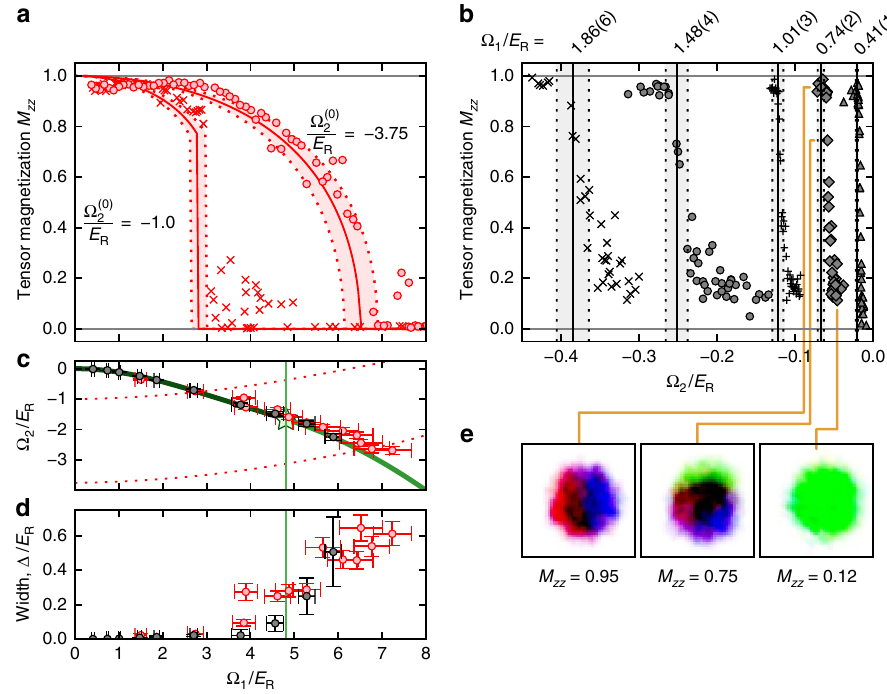
Figure 2 | Measured phase transition. ( a ) Tensor magnetization M zz measured as a function of O 1 , showing both second-order [ O 2 ( O 1 ¼ 0) ¼ (cid:4) 3.7500(3) E R ] and first-order [ O 2 ( O 1 ¼ 0) ¼ (cid:4) 1.0 E R ] phase transitions in comparison with theory. These curves followed the nominally horizontal trajectories (see Methods) marked by red dashed curves in c . ( b ) Tensor magnetization measured as a function of O 2 at O 1 / E R ¼ 1.86(6), 1.48(4), 1.01(3), 0.74(2), and 0.41(1), plotted along with the predicted critical O 2 . In a , b the light-coloured region reflects the uncertainty in theory resulting from our E 5% systematic uncertainty in O 1 . ( c , d ) Phase transition. Black (red) symbols depict data obtained using vertical (nominally horizontal) cuts through the phase diagram. ( c ) measured phase transitions plotted along with theory: solid (phase transition), and green vertical line (tricritical point, O (cid:5) bars correspond to one s.d. on O 1 and vertical error bars are the 95% confidence intervals from the fitting function that determines the critical point. ( d ) 20 to 50% transition width showing the clear shift from first- to second-order with increasing O 1 . ( e ) Domain formation for O 1 ¼ 0.74(2) showing interaction- driven spin structure near the first-order phase transition. In all images, red corresponds to spatial regions with local M z E (cid:4) 1, the green regions correspond to M z E 0 and the blue regions correspond to M z E þ 1. In the polar regime at M zz ¼ 0.12 only the m F ¼ 0 cloud is visible; near the first-order phase transition at M zz ¼ 0.75 all three m F ¼ 0 clouds are visible and have partially phase separated; and in the ferromagnetic regime at M zz ¼ 0.95 only m F ± 1 clouds are visible and they have completely phase